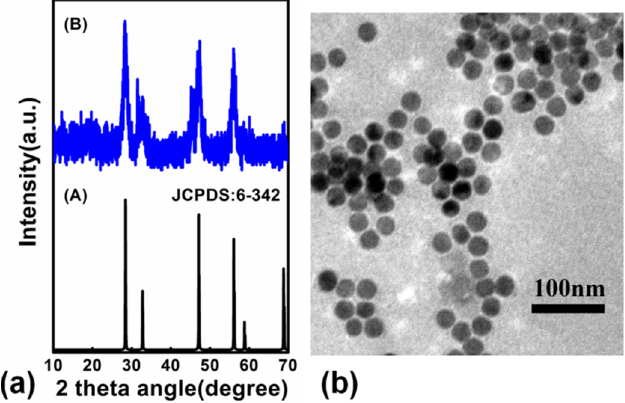
Figure 3. ( a ) XRD patterns of ( A ) standard NaYF 4 NPs (JCPDS-6-342) and ( B ) NaYF 4 :18%Yb 3+ ,1%Er 3+ NPs; ( b ) TEM images of NaYF 4 :18%Yb 3+ ,1%Er 3+ NPs.